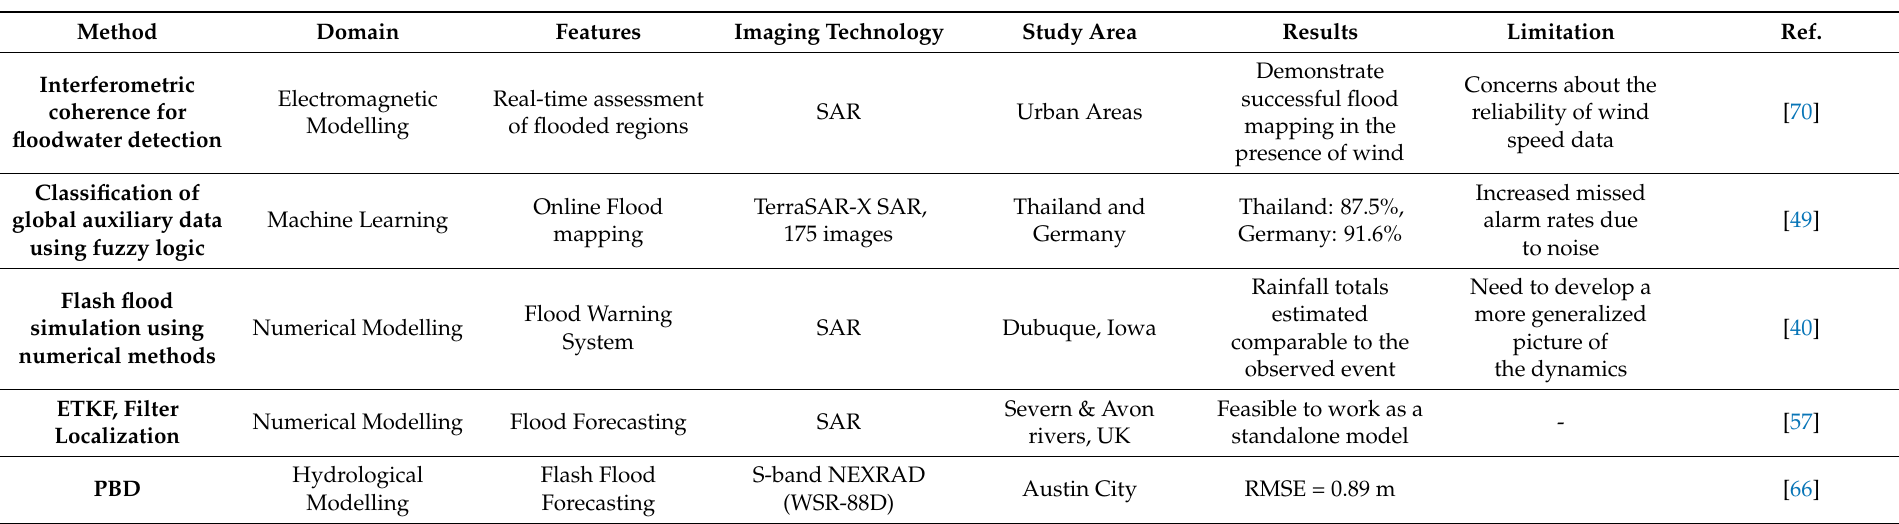
Table 4. Radar technologies for flood